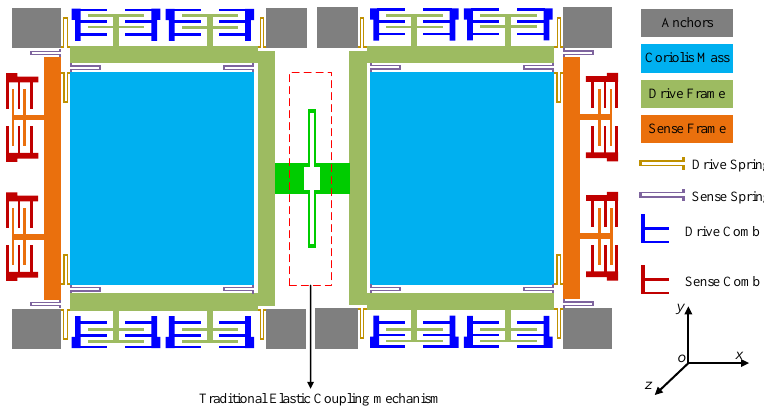
Figure 11. The dual-mass structure coupled via elastic springs.